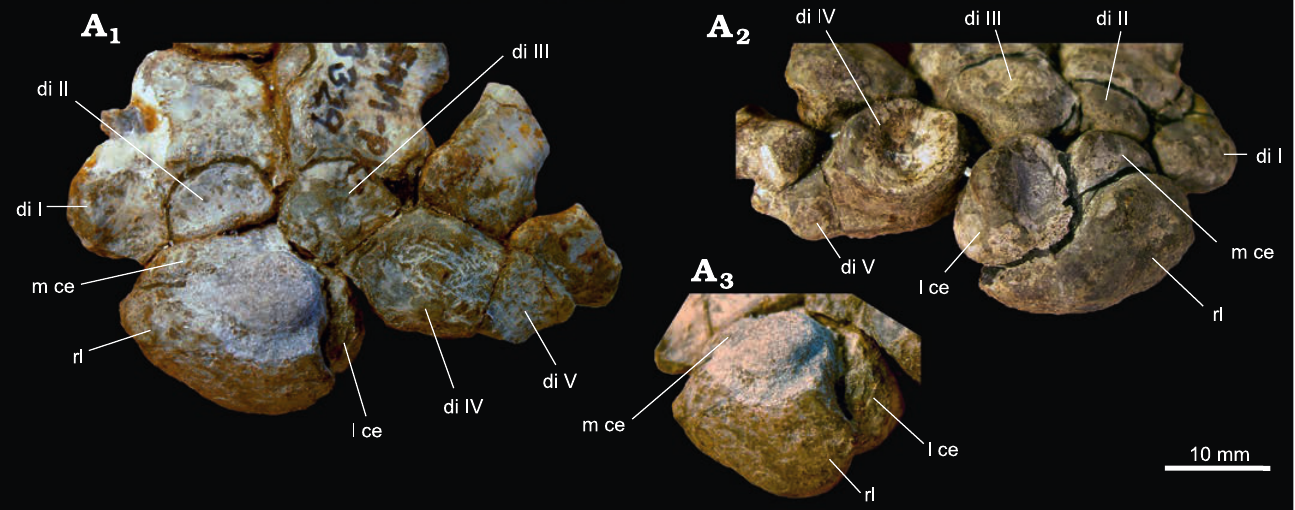
Fig. 11. Part of the carpus of Arctognathus curvimola (Owen, 1876), SAM-PK-3329, Oudeberg, Graaff-Reinet, South Africa, Cistecephalus Assemblage Zone, Lopingian. Dorsal (A 1 ), ventral (A 2 ), and dorsolateral (A 3 ) views, showing the fusion lines between the radiale and the centralia. Abbreviations: di, distal carpal; l ce, lateral centrale; m ce, medial centrale; rl,